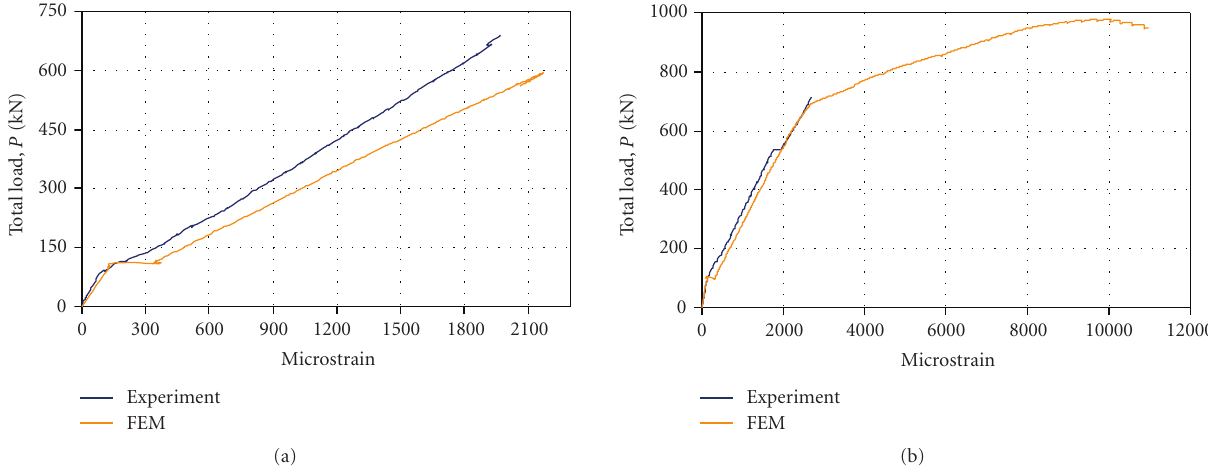
Figure 5: Load-tensile strain plots for FRP composites. (a) Flexural-strengthened beam; (b) flexural plus shear-strengthened beam (experimental beam did not